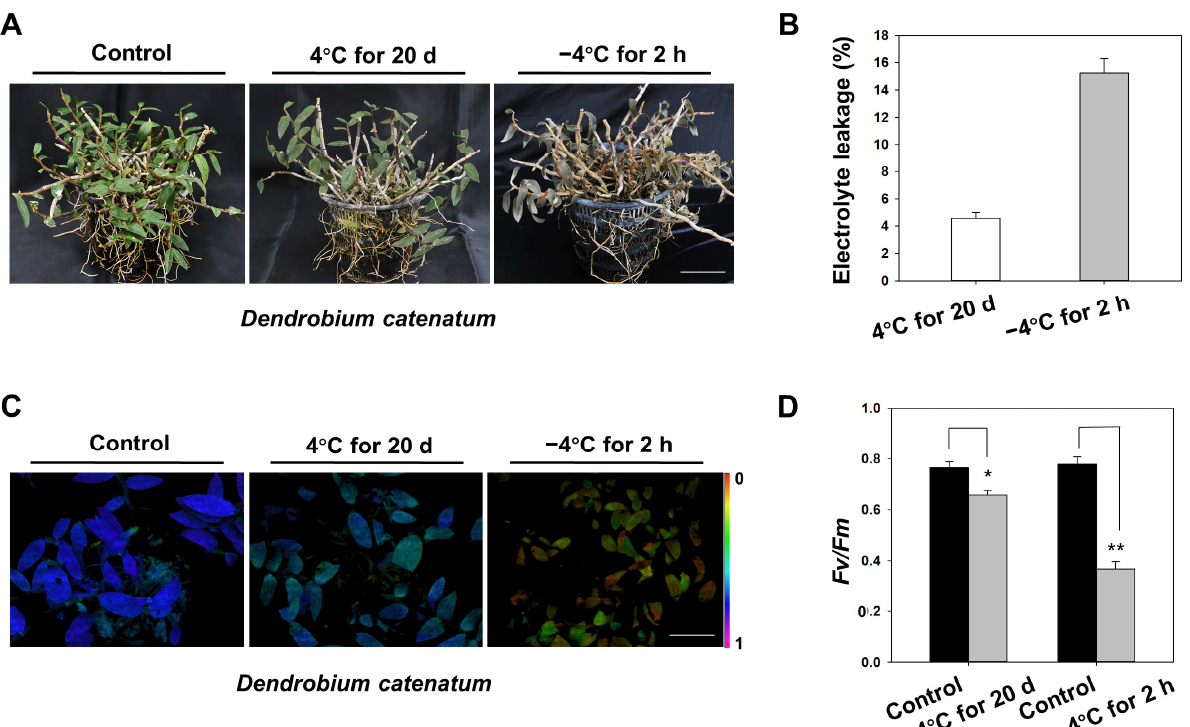
Figure 1. Analysis of cold resistance of D. catenatum . ( A ) Representative phenotypes of plants under chilling (4 ◦ C for 20 d) and freezing ( − 4 ◦ C for 2 h) conditions (bar = 5 cm). ( B ) Electrolyte leakage (EL) of the leaves of D. catenatum after chilling (4 ◦ C for one week) and freezing ( − 4 ◦ C for 2 h) stress. ( C ) Chl fluorescence imaging of D. catenatum after chilling and freezing stress (bar = 2 cm). ( D ) Fv / Fm ratios of D. catenatum after chilling and freezing stress. Data are the mean ± SD of three independent biological replicates. Statistical analyses were performed using a Student’s t test. **, p < 0.01; and *, p <